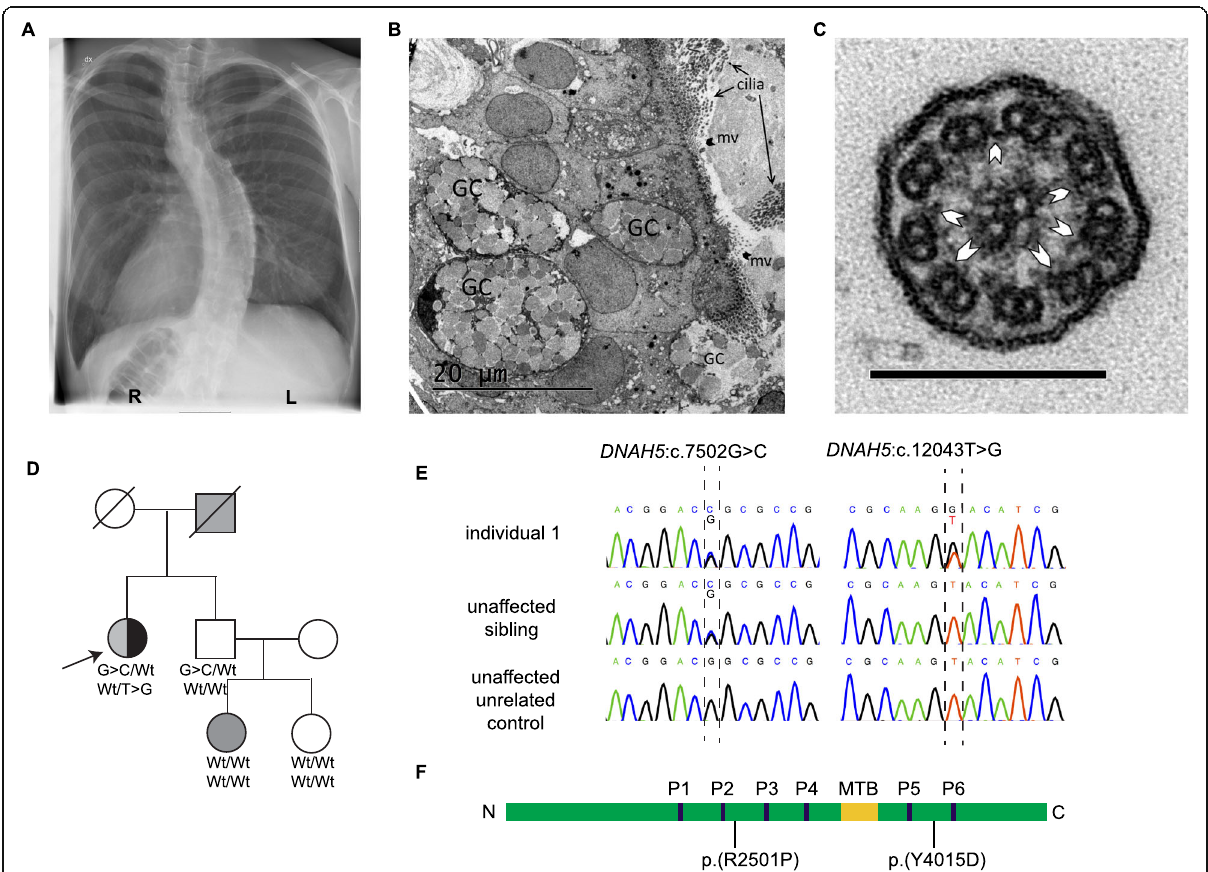
Fig. 1 Phenotype and genetics individual 1. a X-Ray image showing situs inversus and left convex scoliosis. b Low magnification electron micrograph of biopsy from nasal respiratory mucosa showing hyperplasia of goblet cells (GC), reduced number of cilia and increased number of microvilli (mv). c High magnification electron micrograph of a cilium from the epithelial cells showing lack of outer dynein arms and normal inner dynein arms (arrowheads), normal radial spokes and central pair. Scale bar = 200 nm. d Pedigree. Individual 1 (arrow) has PCD (black) and DD (gray). The father and the niece are affected by DD (gray). Unaffected individuals are shown in white. The genotypes of the two variants in DNAH5 are indicated in the affected individual and in the unaffected brother (G > C denotes c.7502G > C, T > G denotes c.12043T > G, Wt denotes wildtype). e Sanger DNA sequencing chromatogram of individual 1 and controls. f Schematic representation of the domains of DNAH5 and localization of the amino acid substitutions p.(R2501P) and p.(Y4015D). N =N-terminus, C=C-terminus, MTB = microtubule-binding